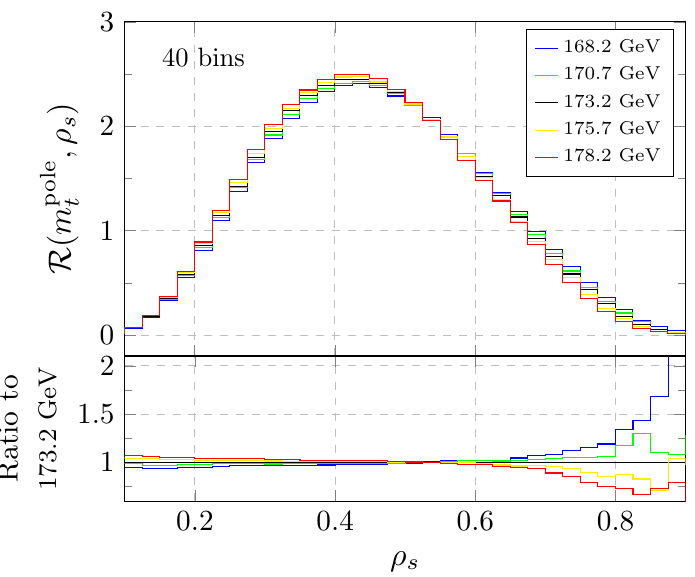
(cid:22) bj + X + (cid:23) e (cid:22) (cid:0) (cid:22) (cid:23) (cid:22) b